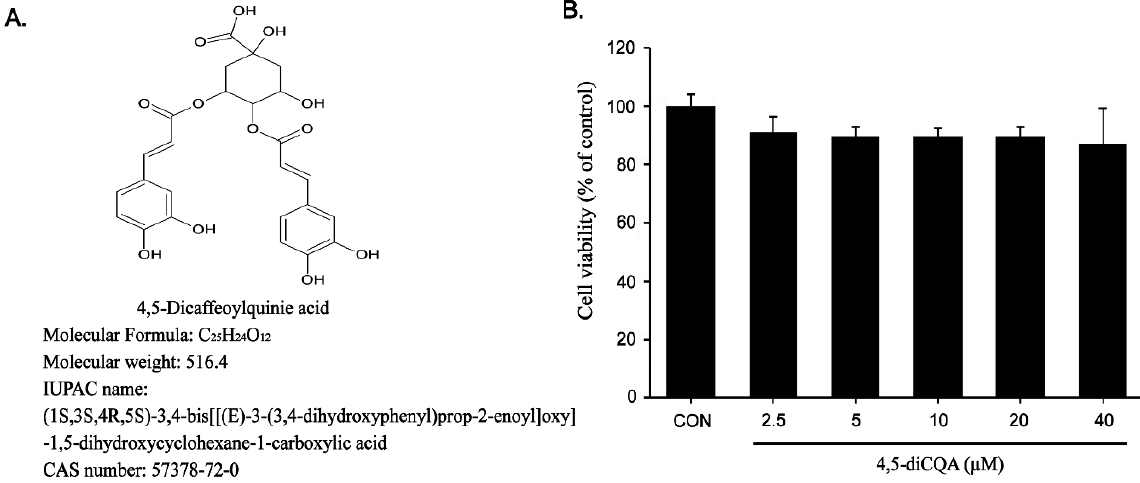
Figure 1. Effects of 4,5-diCQA on RAW264.7 cells viability. ( A ) Chemical formula of 4,5-diCQA. ( B ) Cells were treated with 4,5-diCQA (2.5, 5, 10, 20, and 40 µM) for 24 h, and viability was determined by MTT assay. Cells incubated without 4,5-diCQA were used as controls and considered as 100% viable. Data are represented as the mean ± SD of three independent experiments. CON; control.